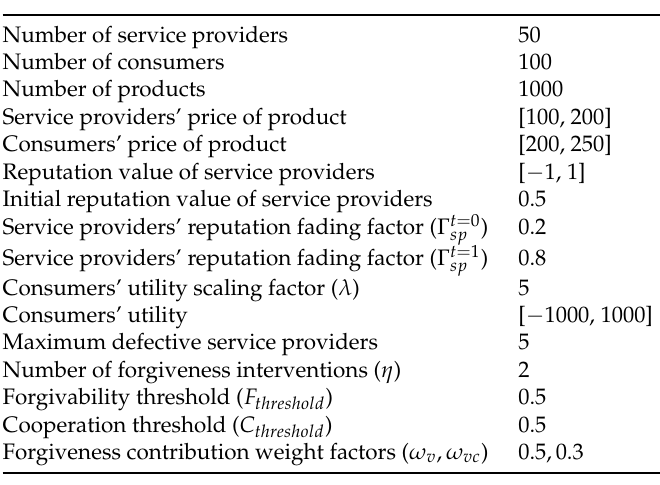
Table 2. Summary of experimental